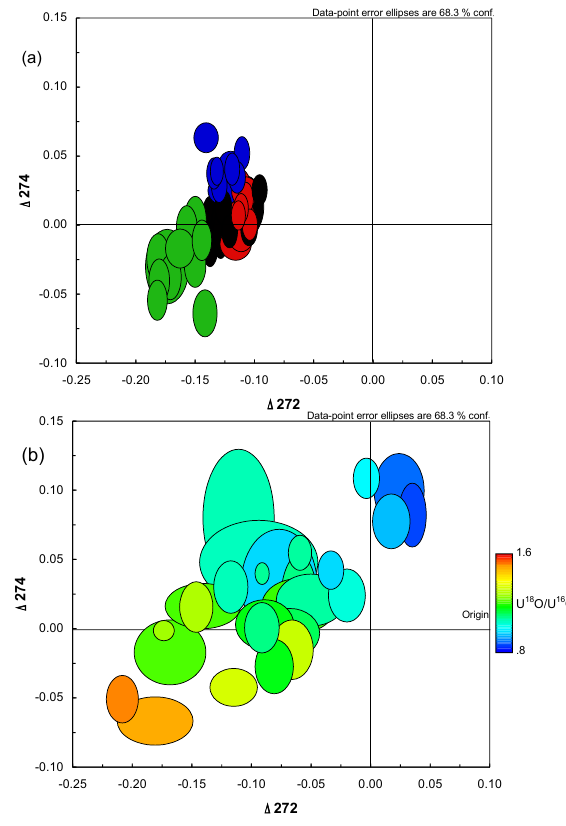
Figure 4. (cid:49) 272 vs. (cid:49) 274 plots for baddeleyite. (a) Four oriented megacrysts with repeated measurements on each. (b) Randomly ori- ented unknowns.